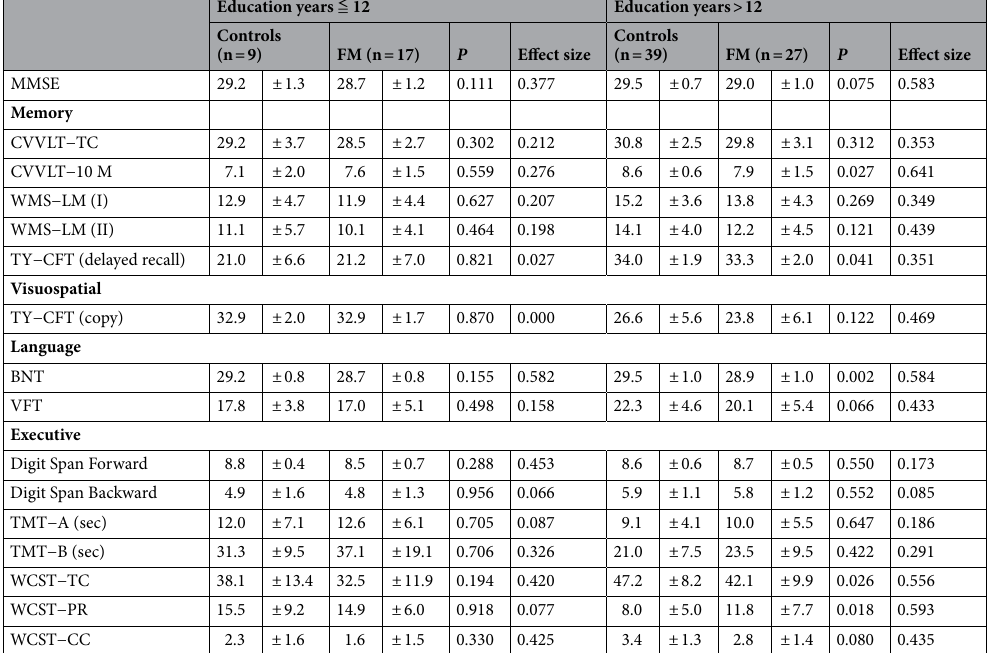
Table 4. Results of objective cognitive tests, stratified according to education. All data are raw score (mean ± SD). Effect sizes are expressed as Hedges’ g. FM fibromyalgia, MMSE Mini–Mental State Examination,